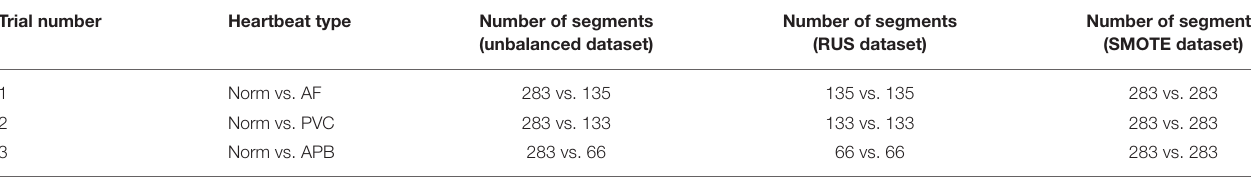
TABLE 2 | The statistics of different categories in this study. Trial number Heartbeat